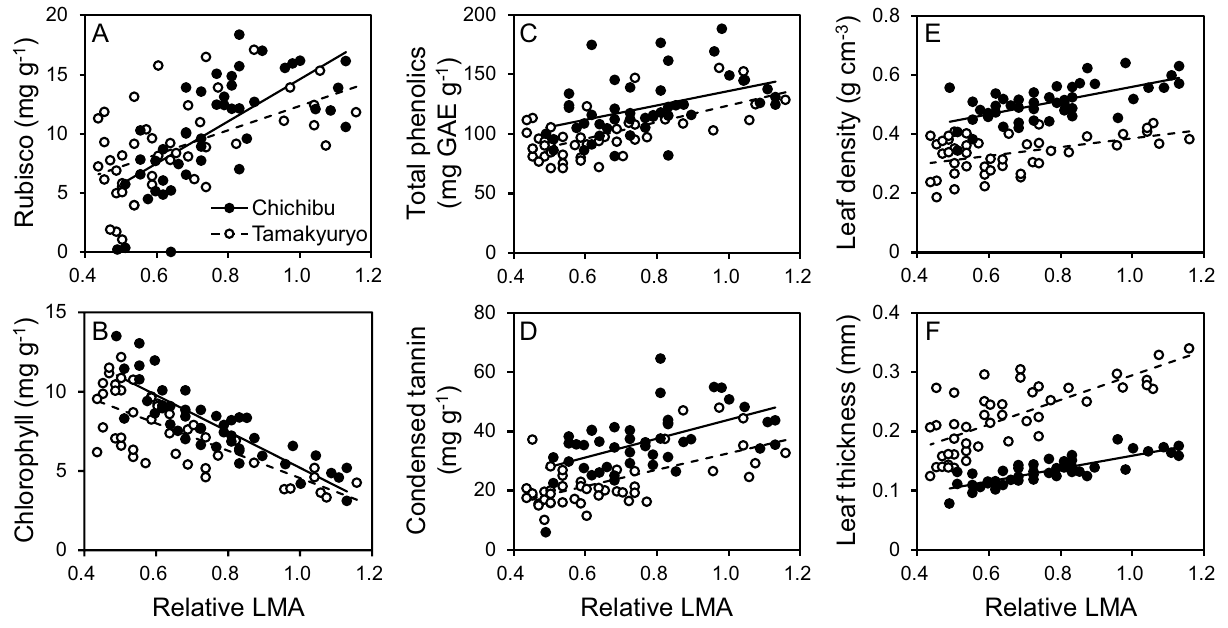
Figure 2. Concentration of ( a ) Rubisco, ( b ) chlorophyll, ( c ) total phenolics, and ( d ) condensed tannin; ( e ) leaf density; and ( f ) leaf thickness as a function of relative LMA of leaves of Q. serrata grown in FM Tamakyuryo in July 2018 (while circle) and FM Chichibu in August 2018 (black circle) (n = 45, except Rubisco: n = 44). Dotted and solid lines indicate regression line of FM Tamakyuryo and FM Chichibu, respectively. Regression lines were drawn when there was a significant effect of relative LMA. Total phenolics concentration is expressed as mg of gallic acid equivalent per